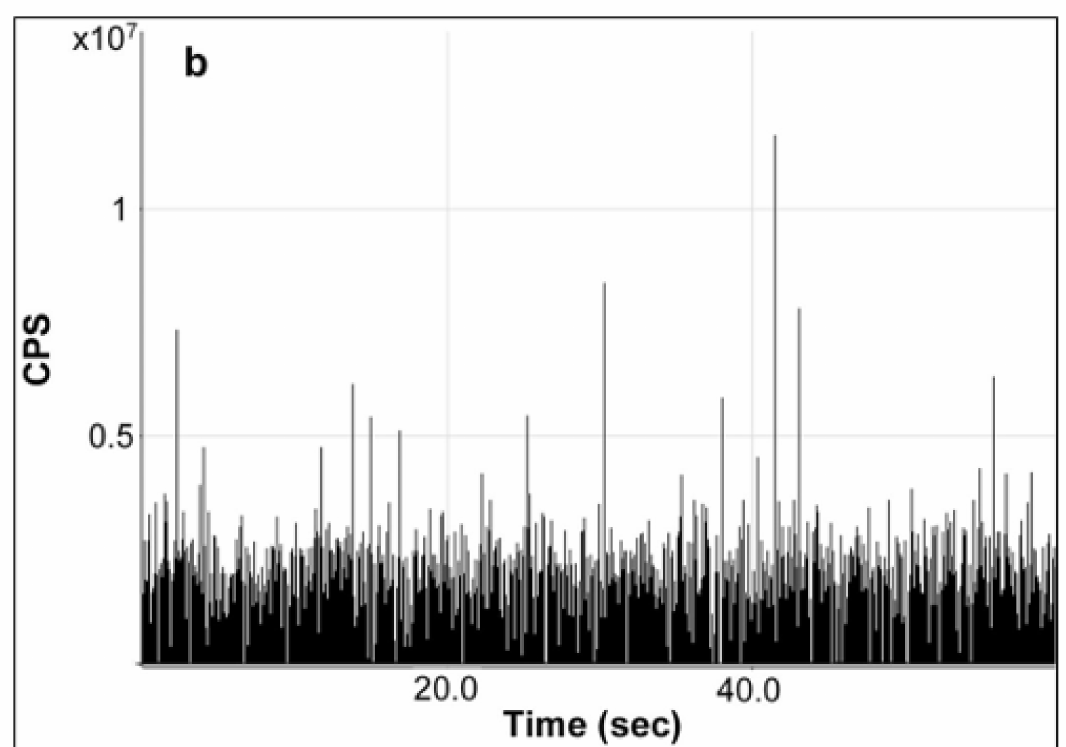
Figure 5. SP-ICP-MS time scan of 107 Ag for analysis of samples of ( a ) the water blank and ( b ) the diluted enzymatic digest of milk spiked with 80-nm AgNPs standard at a mass concentration of 285 µ